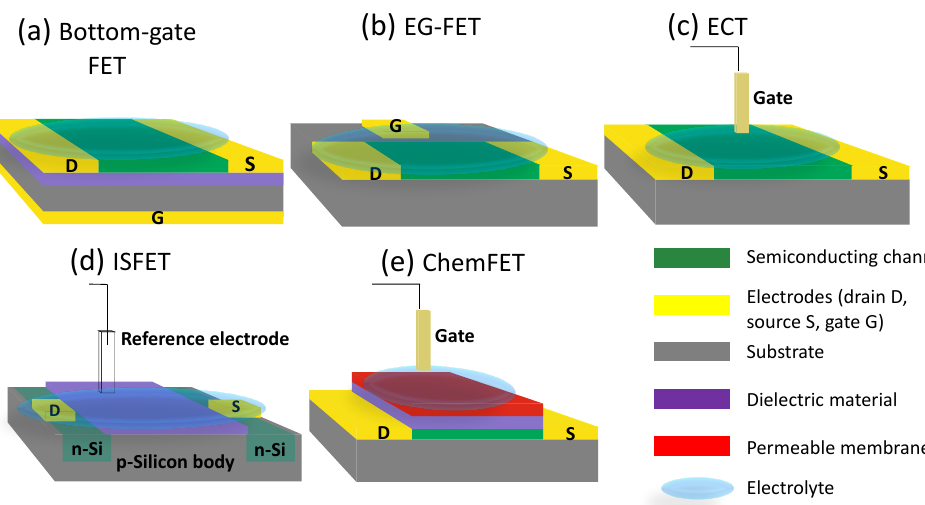
Figure 2. Some of the most common structures of FET devices that are used as biosensors, i.e., as bio-FETs. All structures have source and drain electrodes (in yellow), a semiconducting channel (in green), and a substrate (in gray). ( a ) Bottom-gate FET; the substrate is Si, while the dielectric material is SiO 2 . ( b ) EG-FET (planar configuration); gate is in-plane with source/drain and is insulated through the electrolyte solution. ( c ) ECT; the gate is an external electrode and is dipped in the electrolyte solution. ( d ) ISFET; the gate electrode is replaced by a reference electrode (very often an Ag/AgCl electrode). ( e ) ChemFET; the gate electrode is separated from the source and drain by an electrolytic solution, and a semi-permeable membrane is present at the gate